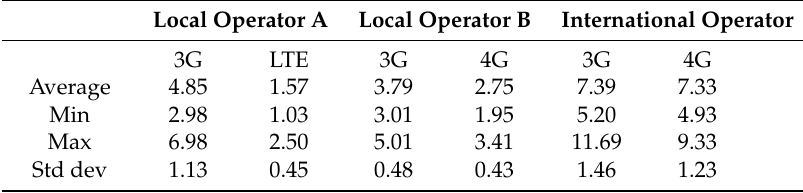
Figure 5. The empirical CDFs of the time it takes to receive an OTP: ( a ) Local operator A; ( b ) Local operator B; ( c ) International. Table 2. Time for OTP verification during payment transactions.